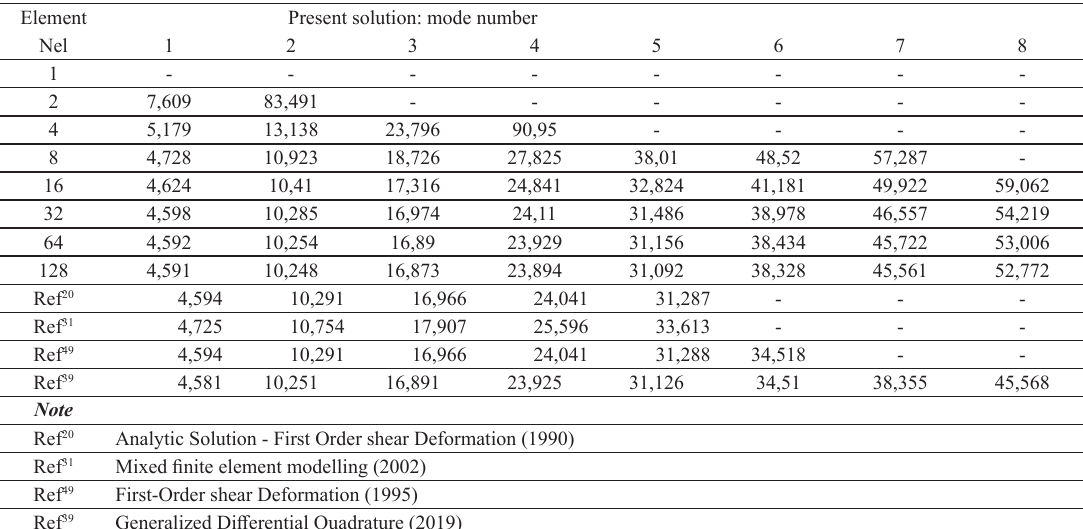
Table 5. Error values in the first natural frequency (CC). Without parasitic shear With parasitic shear Table 6. Natural frequencies (nondimensional values) for CC beam - Laminated composite with (0/90/90/0) lamination scheme. Model corrected for parasitic shear. Element